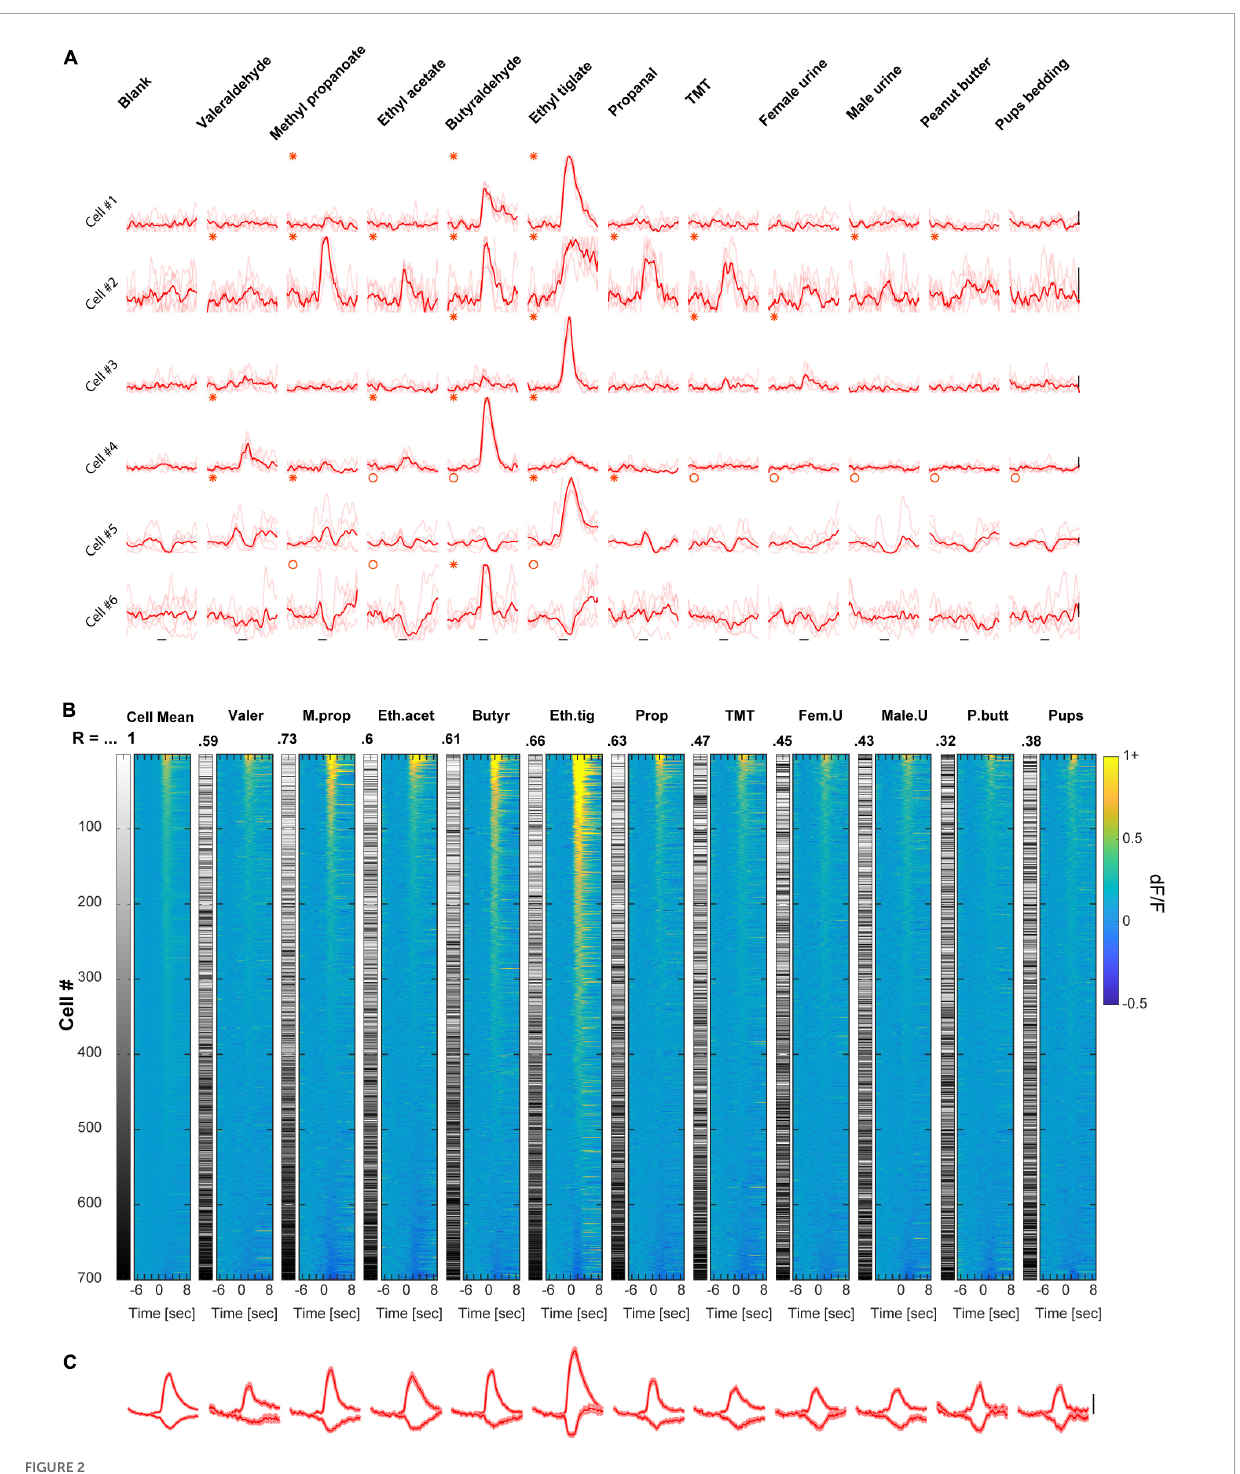
FIGURE2 Mitral cell (MC) responses in the anesthetized state: unbalanced response profile across odors. (A) Examples of odor-evoked calcium transients from an anesthetized mouse, for 6 neurons and 11 odors. Odor stimulation is denoted as a black horizontal line below all traces (2 s). Thin traces are five single trials; thick traces are means. Red asterisks denote significant excited responses and red circles denote significant suppressed response. Scale – vertical black lines, 30% dF/F. (B) Colored columns- All data recorded from anesthetized mice, sorted by magnitude per each stimulus separately. Greyscale columns- Ranks of Cells’ average response fitted to each cell-odor pair. Spearman correlation coefficients denote the rank correlation between the MC population average response and the population response to each one of the odors. Full odor names are depicted in panel (A) . (C) Average traces of population S and E responses for each of the odors presented. Scale – vertical black line, 20% dF/F. Traces are presented as mean response (thick lines), and shadows are the SEM. Each trace represents 7 s pre-stimulus, 2 s stimulus presentation, and 7 s